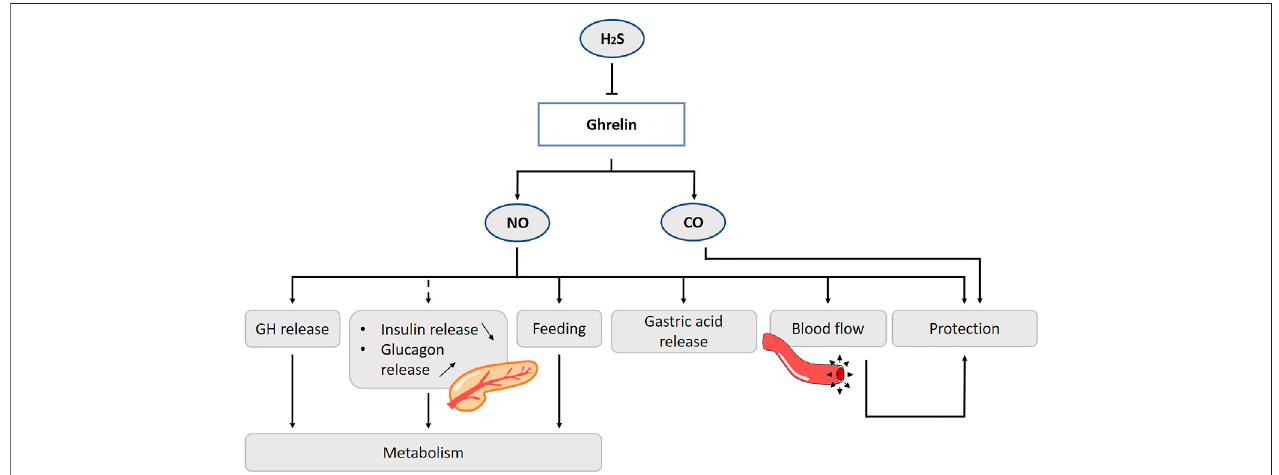
FIGURE 8 | Role of gasotransmitters on ghrelin release and its physiological functions. Solid lines are clear evidence – based on blockers and substrate administration. Dotted lines represent fi rst evidence for the presence of the pathway. The amino acid L -cysteine, which is a H 2 S donor, suppresses ghrelin release from the stomach. Ghrelin promotes the release of GH via activation of the NOS/NO/GC/cGMP-signaling pathway. Ghrelin also promotes feeding behavior and stimulates gastricmotility and acidsecretion viatheNO-pathway. Nodirect evidence isfoundtodatefortheinvolvementofNOintheghrelin-glycemic effect.Ghrelinprotects the gastric mucosa, bystimulationofthe blood fl ow and hyperemia mediated byNO. CO is also involved in the ghrelin-mediated gastroprotection. NO, Nitric oxide; CO, Carbon monoxide; H 2 S, Hydrogen sul fi de; GH, Growth hormone; NOS, Nitric oxide synthase; GC, Guanylyl cyclase; cGMP, Cyclic guanosine